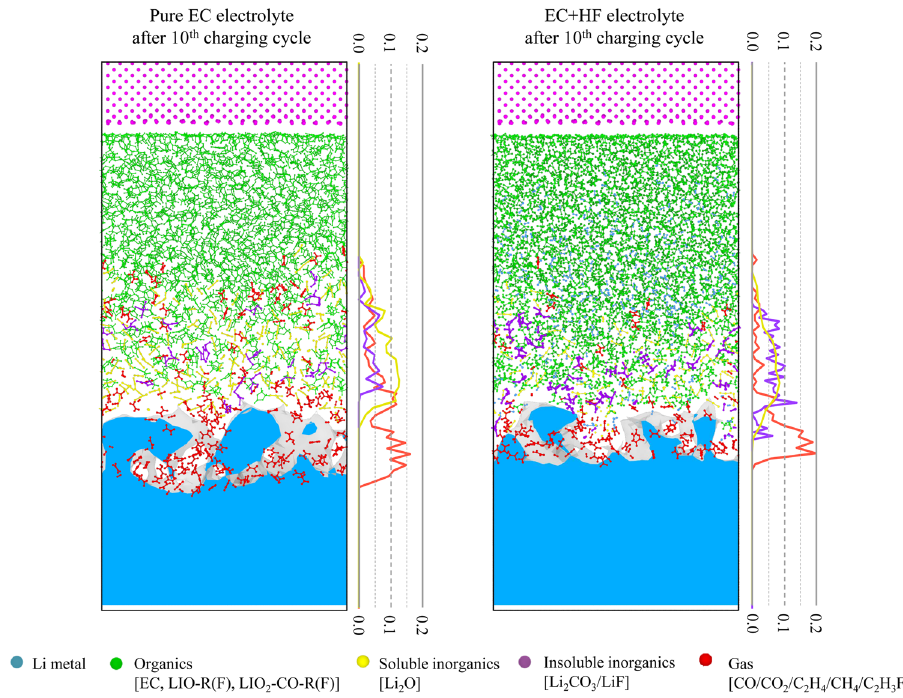
Fig. 8 Distribution of chemical species after the 10 th charging processes of (Left) pure EC and (Right) EC + HF systems. The normalized number density pro fi les (arbitrary units) are attached to the right of the chemical species distributions.